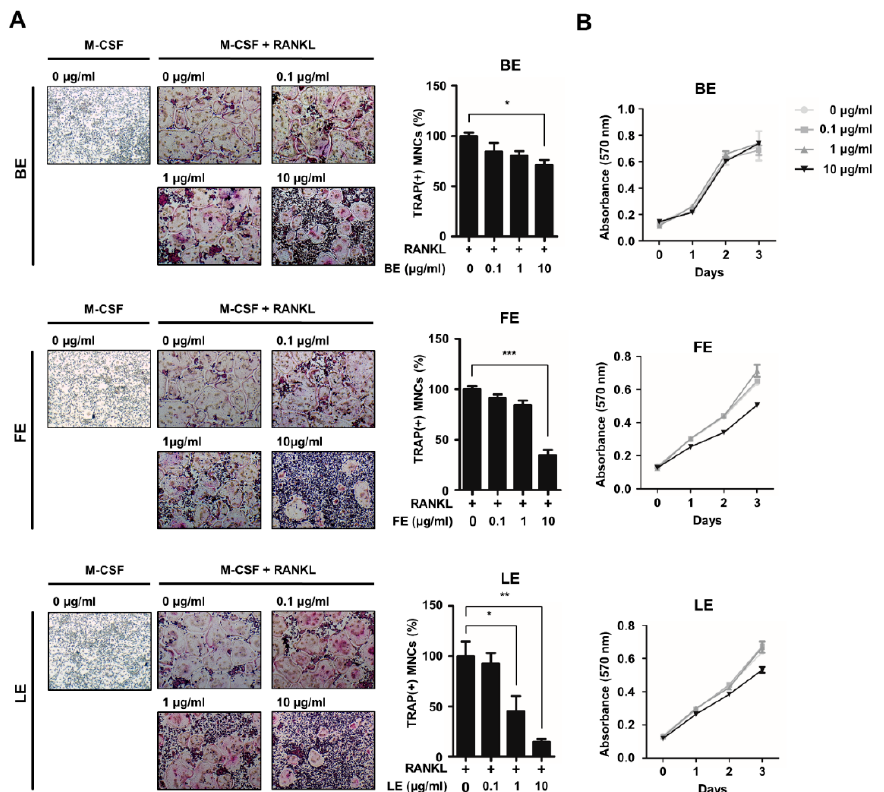
Figure 1. Abeliophyllum distichum extracts suppress osteoclast differentiation. ( A ) BMMs were treated with M-CSF (30 ng/mL) and RANKL (100 ng/mL) in the absence or the presence of increasing concentration of three tissue extracts such as branch extract (BE), fruit extract (FE) and leaf extract (LE) of A. distichum for 3 days. Cells were fixed and stained for TRAP. The representative TRAP staining was shown (left panel) and the number of TRAP-positive multinuclear cells was counted (right panel). ( B ) BMMs were cultured with M-CSF (30 ng/mL) in the presence of extracts of A. distichum and cell proliferation was measured by MTT assays. Error bars represent the mean result ± SD of three independent experiments; * p < 0.05, ** p < 0.01, *** p < 0.001.